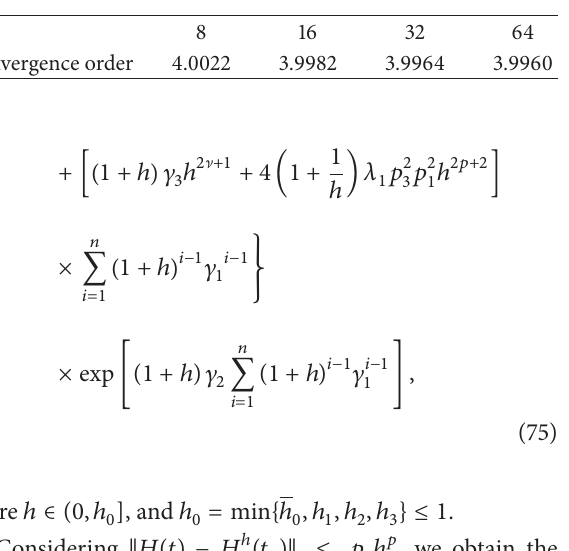
Table 1: Convergence order of two-step Runge-Kutta methods for system